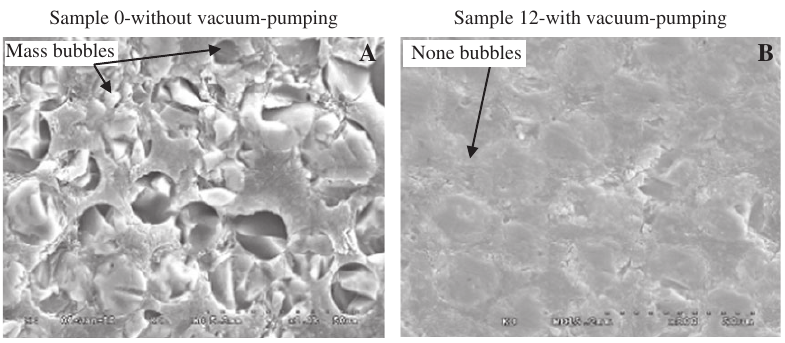
Figure 7 Comparative SEM micrograph of the GFRP-anchor body without and with vacuum-pumping process. (A) Without vacuum-pumping process. (B) With vacuum-pumping process.